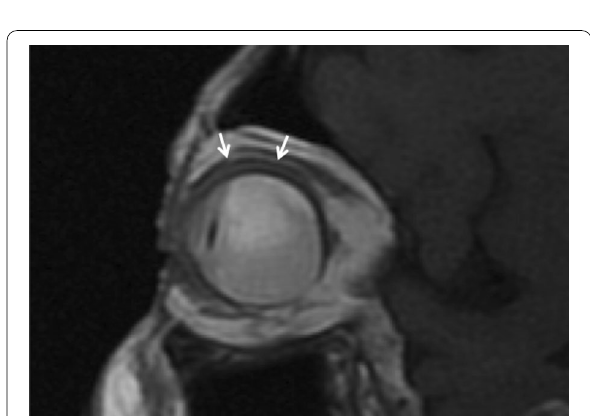
Fig. 16 An 82-year-old man with radiation-induced periocular fibrotic adhesions after brachytherapy for choroidal melanoma of the right eye. The same patient as in Fig. 7. Sagittal T1-weighted image shows soft tissue thickening along the superior outer edge of the sclera (white arrows), a finding consistent with fibrotic